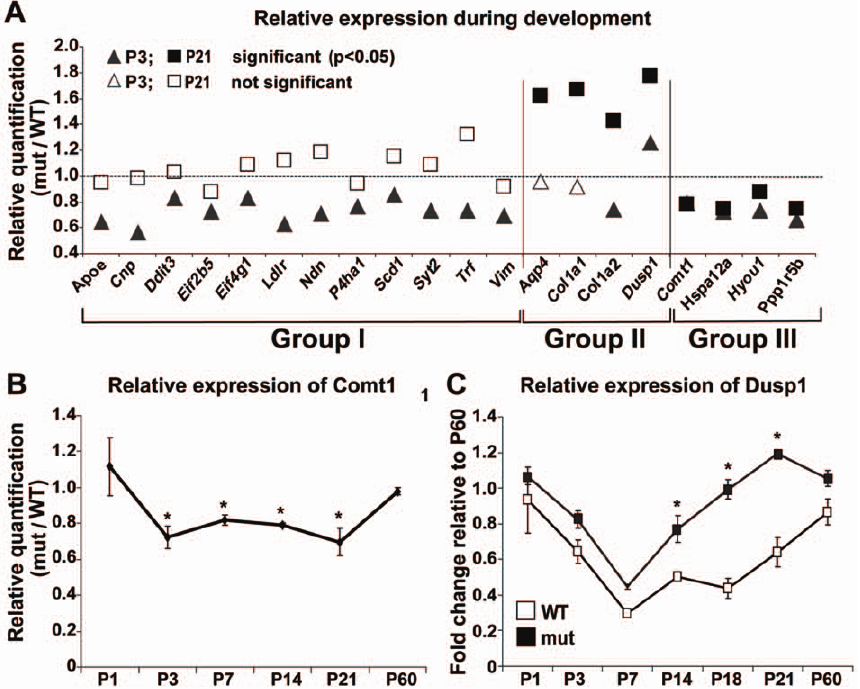
Figure 4. qRT-PCR of selected genes during development. RNA was isolated from the entire brain excluding the cerebellum of wild-type (WT) and mutant (mut) mice at different postnatal stages as indicated, and tested for specific mRNAs level by qRT-PCR using specific primers. Each mRNA expression level is the average of 3 biological samples calculated relative to GAPDH control. (A) P3, triangles; P21, squares. p , 0.05, black; p . 0.05, white. See Table 2 for exact p values of all samples. (B) Relative quantity of Comt1 mRNA level in mut relative to WT mice at P1, P3, P7, P14, P21 and P60. * indicates p , 0.05. (C) Fold change of Dusp1/MPK1 expression level in WT (white) and mut (black) mice at P1, P3, P7, P14, P21 relative to P60. * indicates p ,